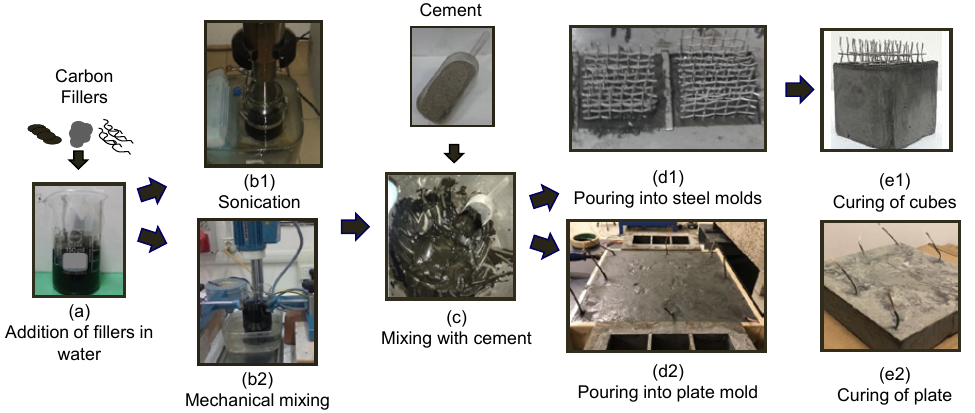
Figure 5. Preparation procedure of smart cementitious composites. ( a ) Addition of carbon fillers in deionized water; ( b1 ) sonication of the aqueous suspension; ( b2 ) alternative mechanical mixing of the water suspension; ( c ) addition of cement to the water suspension; ( d1 ) pouring of the cubes into oiled steel molds and placement of embedded electrodes; ( d2 ) pouring of the plate into mold and placement of embedded electrodes; ( e1 ) curing of cube samples in laboratory conditions.; ( e2 ) curing of plate sample in laboratory